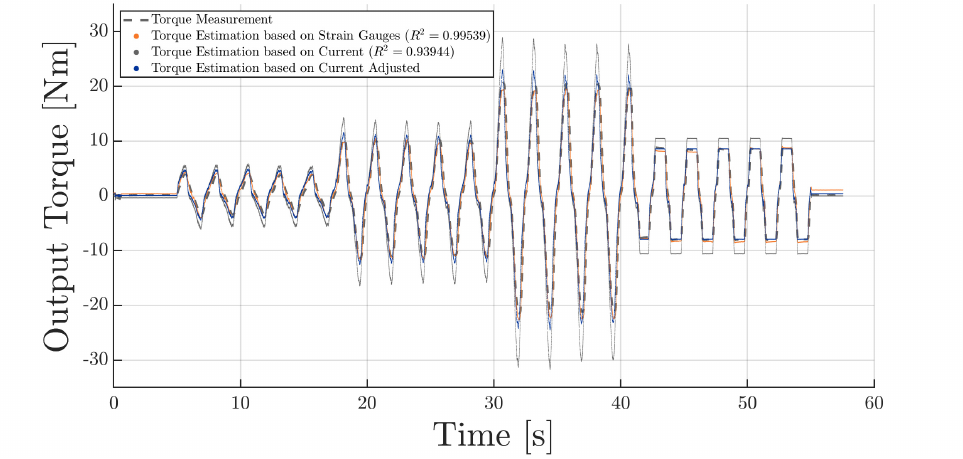
Figure 7. Comparison of the output torque obtained from the strain gauges and from the current with the one measured by the torque sensor. The results obtained from the current tend to overestimate the output torque generated, since it does not include the losses of the actuator. A linear regression can be applied to it, to have a better match with the torques measured by the sensor and by the strain gauges.